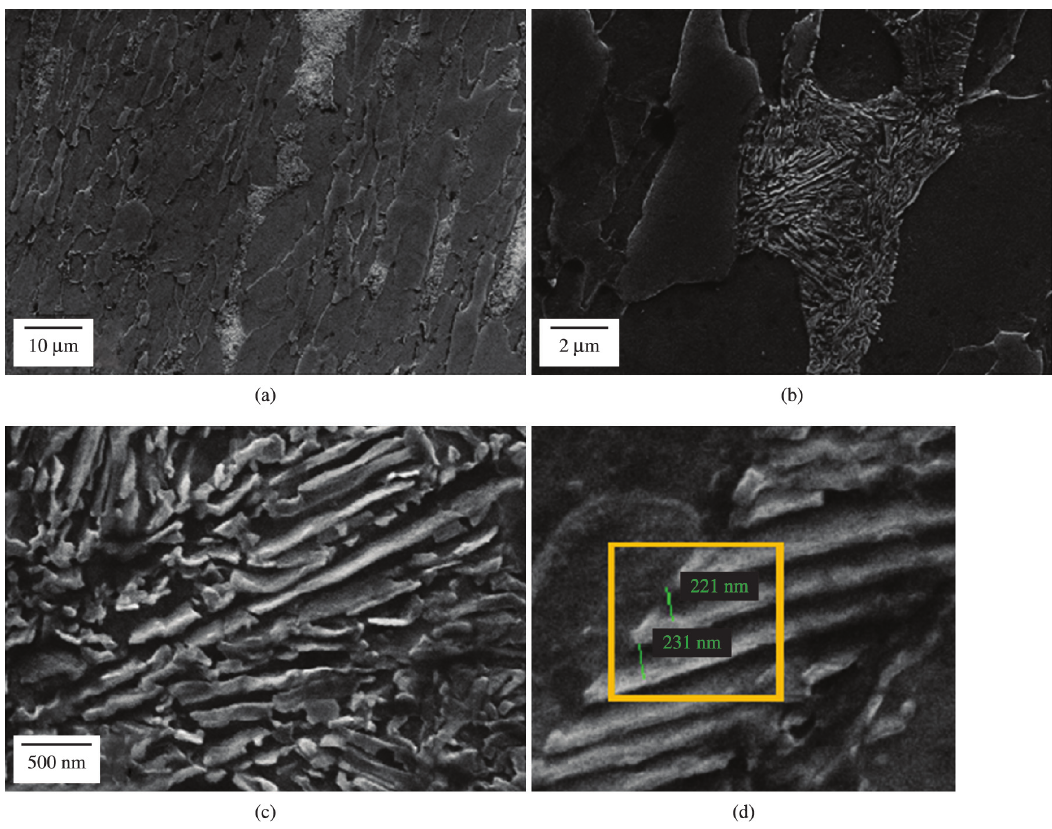
Figure 5. Ferrite and microconstituent pearlite morphology of the X70 steel: a) ferrite and pearlite banding; b) difference of depth between ferrite and pearlite; c) ferrite and cementite lamellae; d) interlamellar distance.